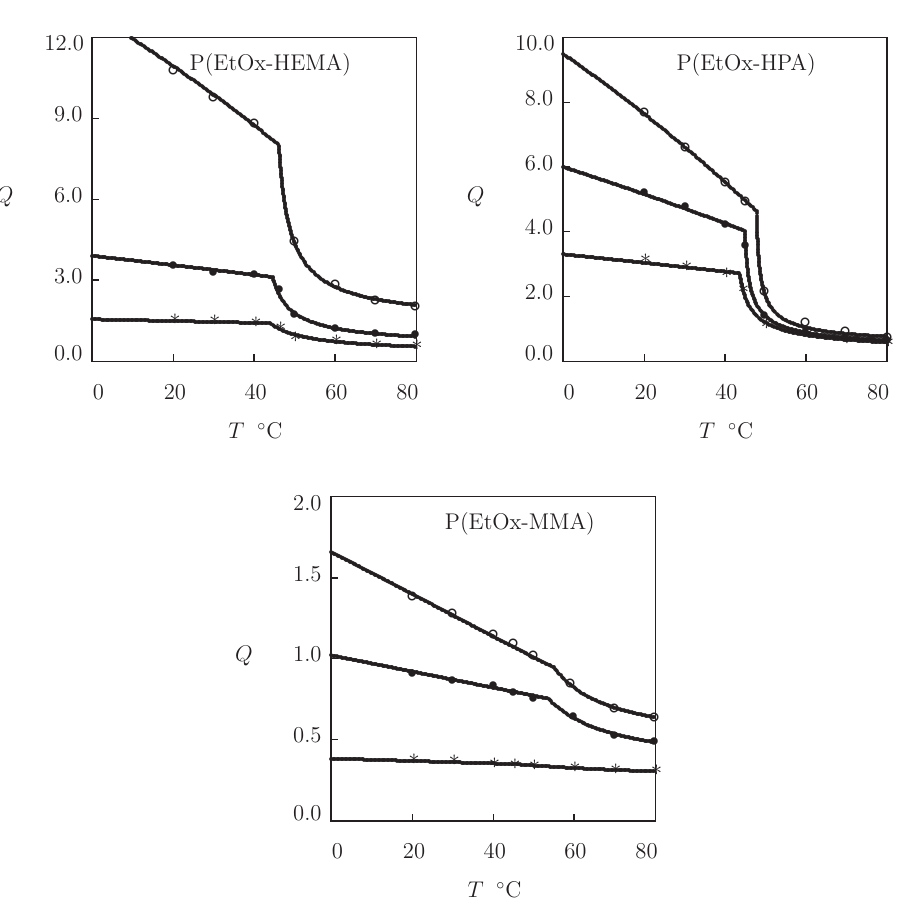
Figure 9. Degree of swelling Q versus temperature T . Symbols: experimental data [88] on P(EOx-HEMA), P(EOx-HPA), and P(EOx-MMA) copolymer gels with various molar fractions ψ on comonomers ( – ψ = 0.3, – ψ = 0.5, – ψ = 0.7). Solid lines: results of ◦ • ∗